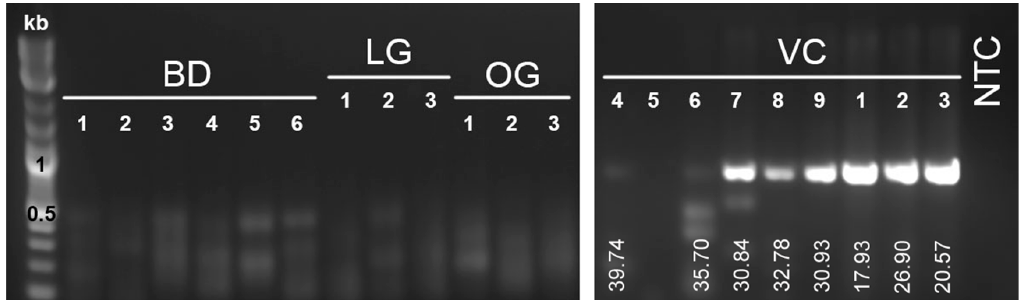
Figure 4. The sanger sequencing of VC3 yielded poor-quality sequence due to coinfection, as observed by metagenomics, but the sequence chromatograms revealed double peaks consistent with coinfection by VCSV-A and -B.